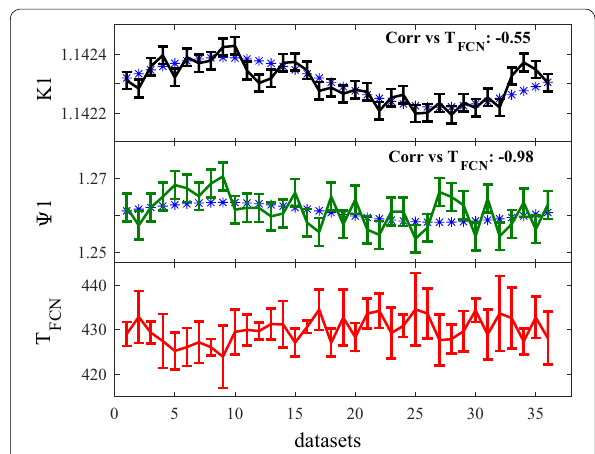
Fig. 1 Fluctuation of the FCN period (red) and the K1 (black) and ψ1 (green) waves fitted from synthetic time series. The blue stars in top and middle panels are the theoretical values of amplitude factor of K1 and ψ1 waves corresponding to the set FCN period in synthetic data. The FCN period (red) is estimated with the tidal parameters of 6 diurnal waves. The “Corr versus T FCN ” represents the correlation coefficient between K1 and ψ1 waves and FCN